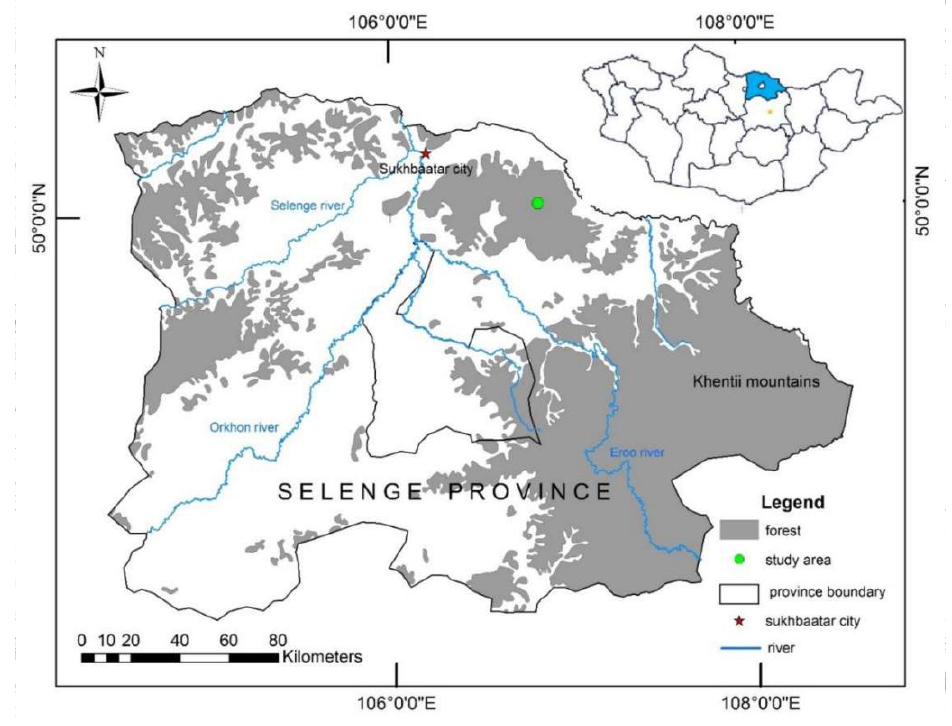
Figure 1. Location of the study area in the Selenge